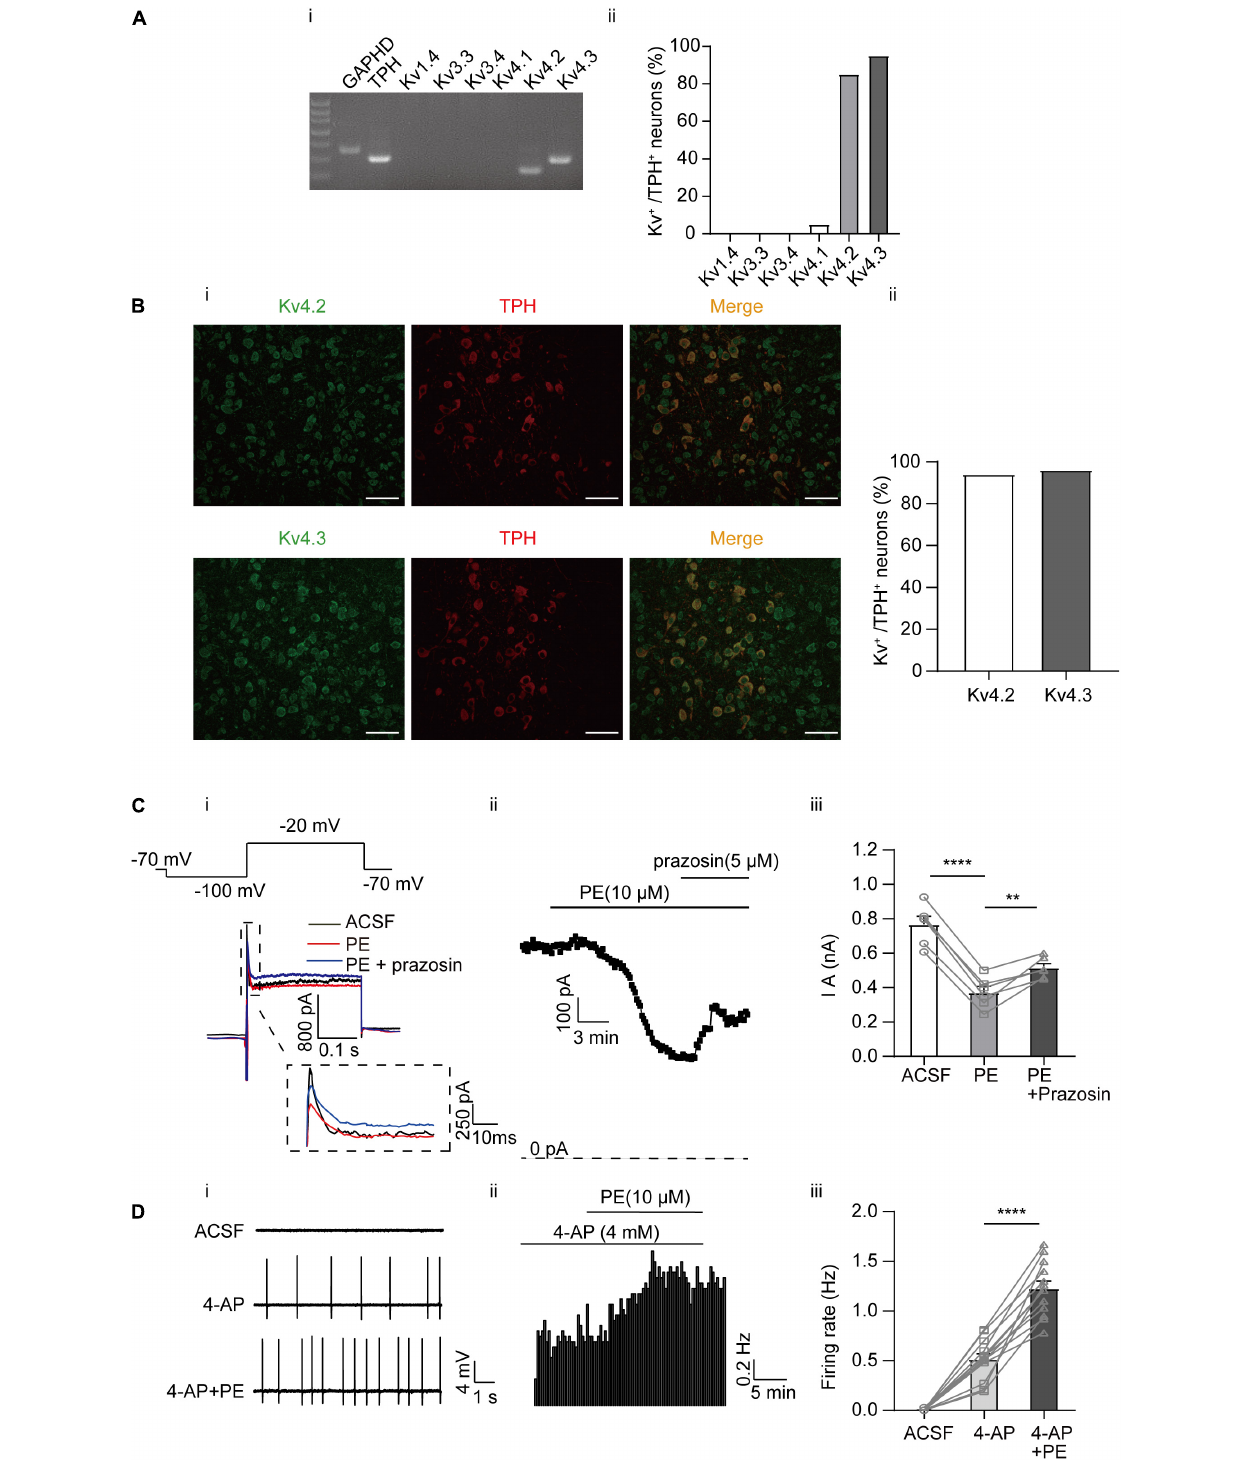
FIGURE 2 | Expression of A-type K + channels and their contribution to the PE-induced spontaneous firing of the DRN 5-HT neurons. (A) Expression of A-type K + channel-related subfamily members assessed using single-cell PCR analysis in the DRN neurons. (i) Representative image of single-cell PCR products showing the presence of different Kv subunits. (ii) Proportion of Kv1.4, 3.3, 3.4, and Kv4s-positive neurons in the TPH-positive neurons ( n = 20). (B) (i) Confocal images of Kv4.2 and 4.3 protein expression in slice of the DRN, assessed using immunofluorescence methods. Scale bar = 50 µ m. (ii) Proportion of Kv4.2 and 4.3-positive